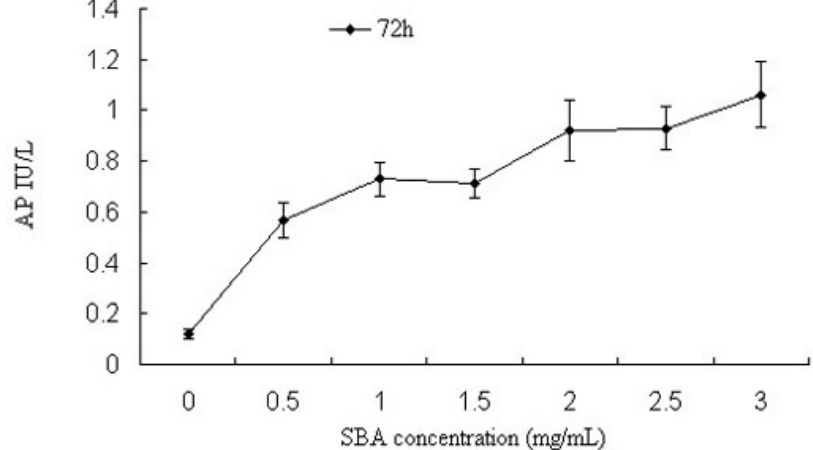
Figure 2. Effects of SBA on AP activity in IPEC-J2 cells. Cells were treated with various concentration of SBA for 72 h, culture supernatants were collected, and AP activity was measured. The control cells were treated with 0 mg/mL SBA for 72 h. Values are the mean ±SD from 4 independent experiments. Treatment of 0.5, 1.0 or 1.5 mg/mL SBA was significantly higher than control ( p < 0.05), and the 2.0, 2.5 or 3.0 mg/mL SBA treatment were even higher than treatment of 0.5, 1.0 or 1.5 mg/mL ( p < 0.05). However, no significant differences were observed among 0.5, 1.0 and 1.5 mg/mL treatment; or 2.0, 2.5 and 3.0 mg/mL SBA treatment ( p >